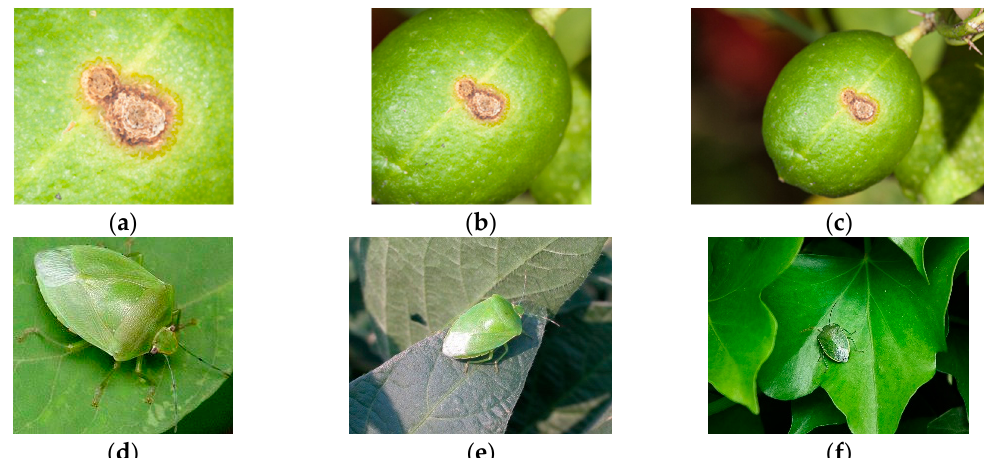
Figure 3. Photos taken with subject at different distances from camera: ( a – c ) citrus canker; ( d – f ) southern green stink bug.